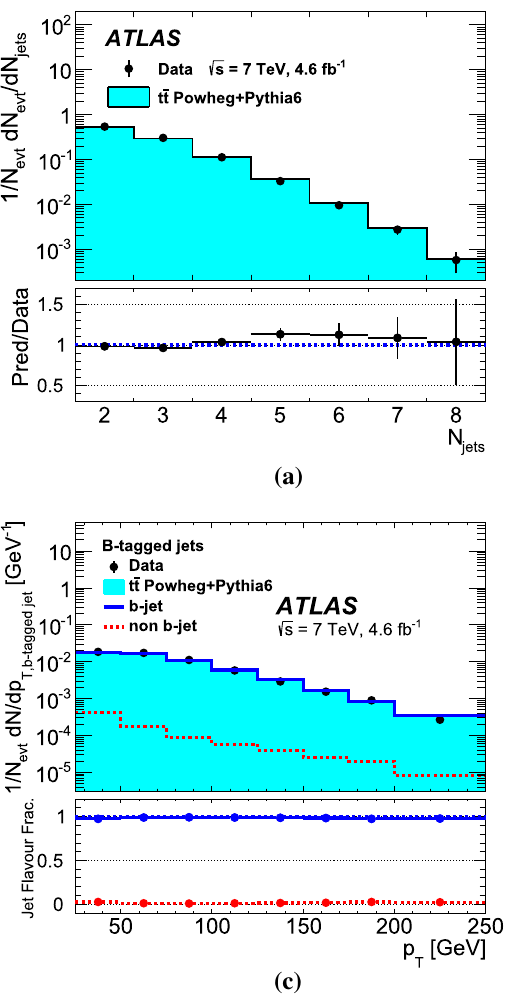
Fig. 1 Spectra of a jet multiplicity N jets and b jet p T in data com- pared with t ¯ t Powheg + Pythia6 predictions at detector level. The expected b -jet flavour fractions for c b -tagged and d non- b -tagged jets